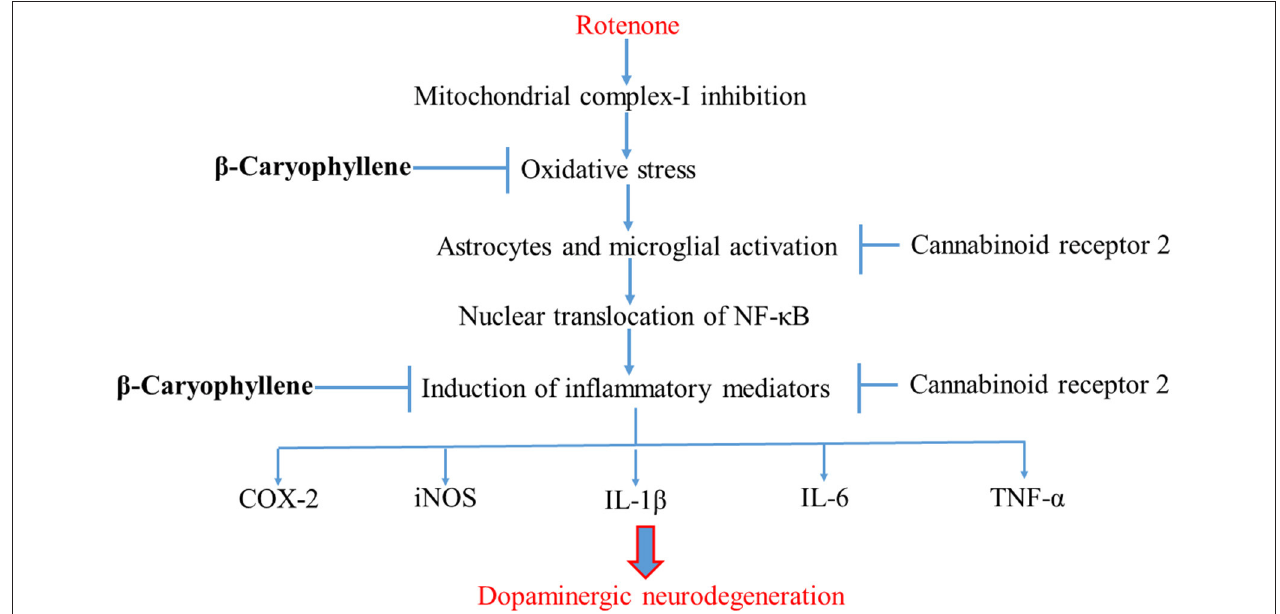
FIGURE 8 | Schematic representation of the neuroprotective mechanism of action of